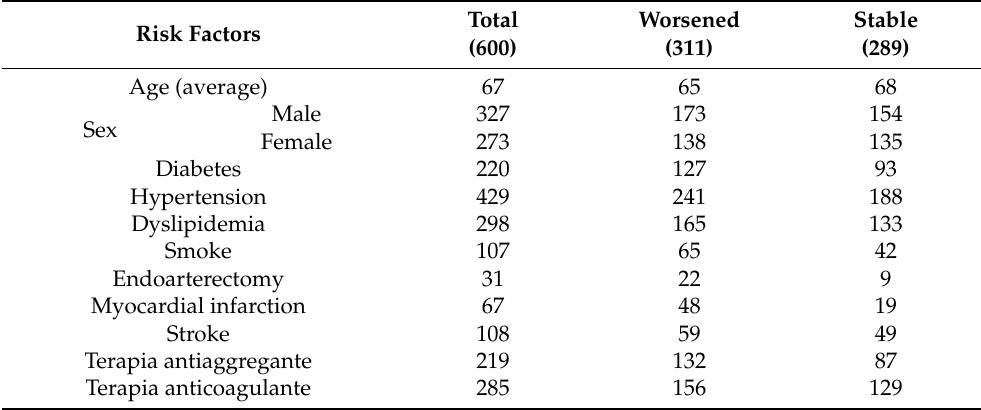
Table 1. Demographic and clinical data for the patients in total and for the two groups.